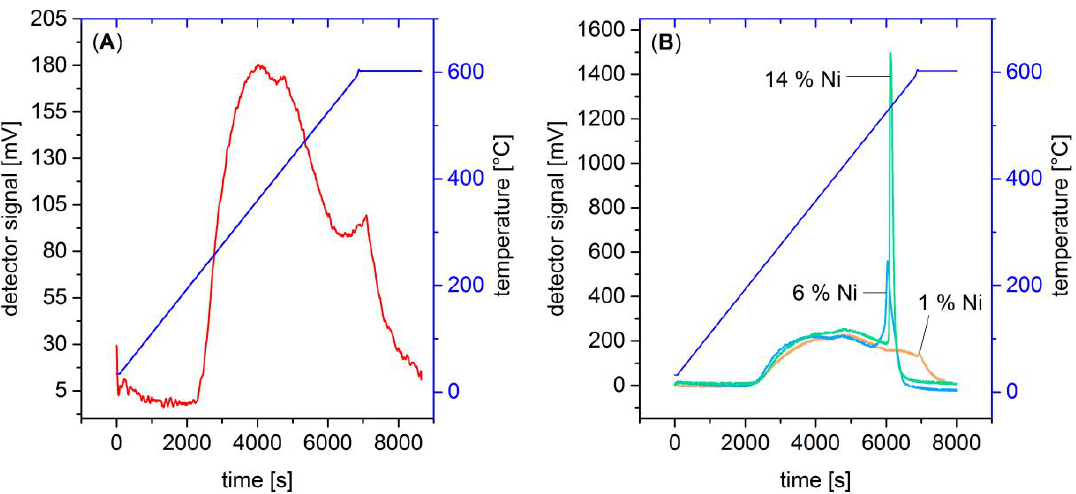
Figure 7. Temperature programmed desorption of ammonia after removal of physisorbed compounds at 200 °C; ( A ) profile of amorphous aluminosilicate in proton form and ( B ) of impregnated samples with varying nickel content.